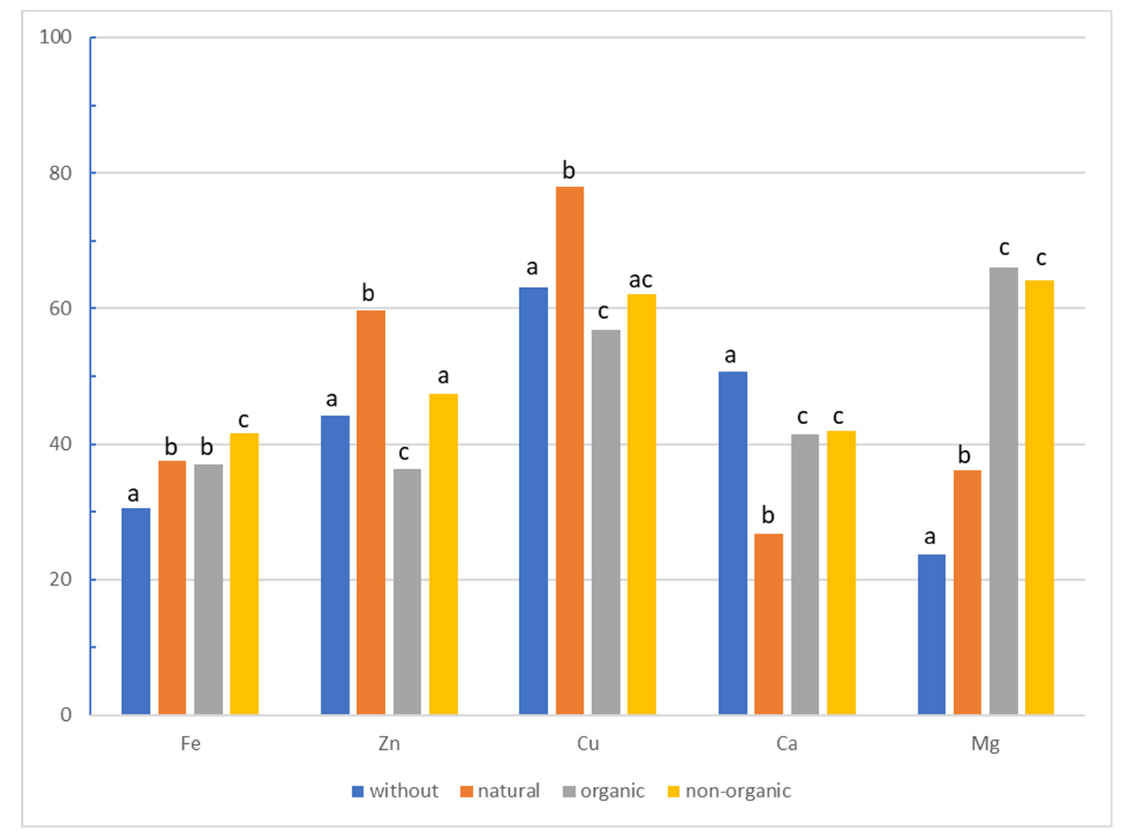
Figure 4. Effects of the type of additive (no additive, seeds, synthetic organic and non-organic compounds) on the bioavailability of minerals (ANOVA main effects) (%), a, b, c statistical differences between additives (seeds, supplements).